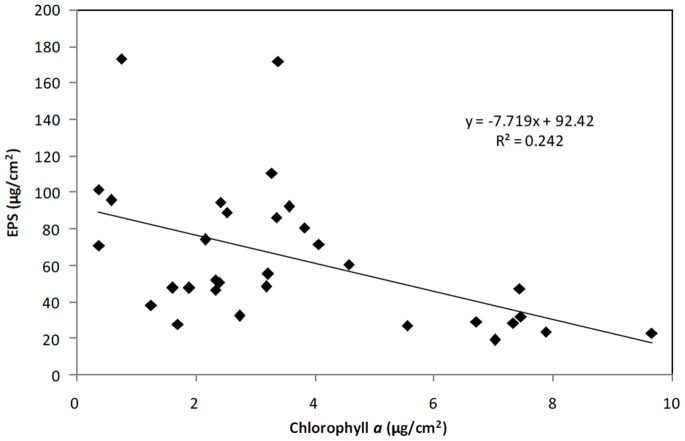
Relationship between chlorophyll a and exopolysaccharides (EPS).